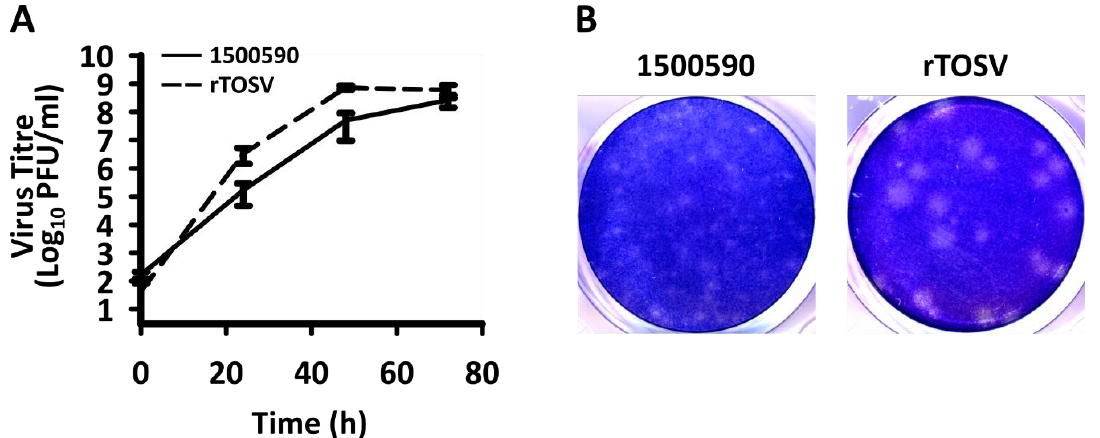
Figure 3. Rescue of TOSV. ( A ) rTOSV (virus rescued by three plasmid system) replication as compared with TOSV 1500590 on A549 NPro cells. The timecourse was repeated twice independently with similar results, N = 3. Error bars show standard deviations; ( B ) Plaque morphology of TOSV 1500590 (left panel) and rTOSV (right panel) on A549 NPro cells after 72 h.